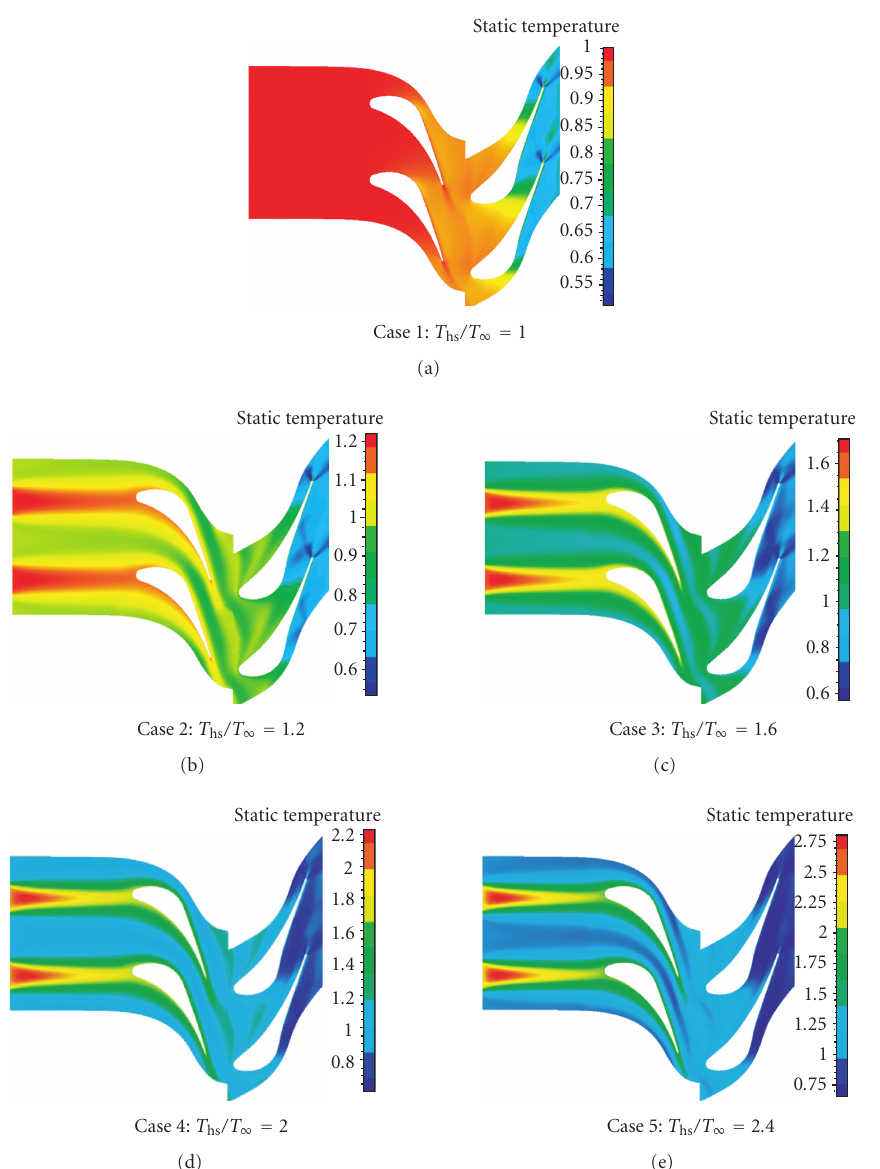
Figure 9: Temperature contours at the midspan of the HPT.